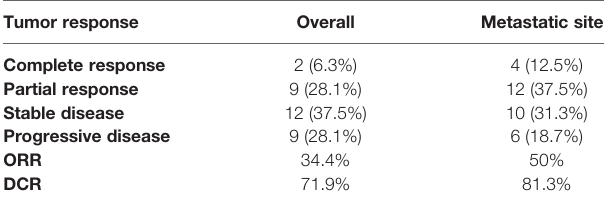
TABLE 2 | The tumor response for overall tumor burden and metastatic